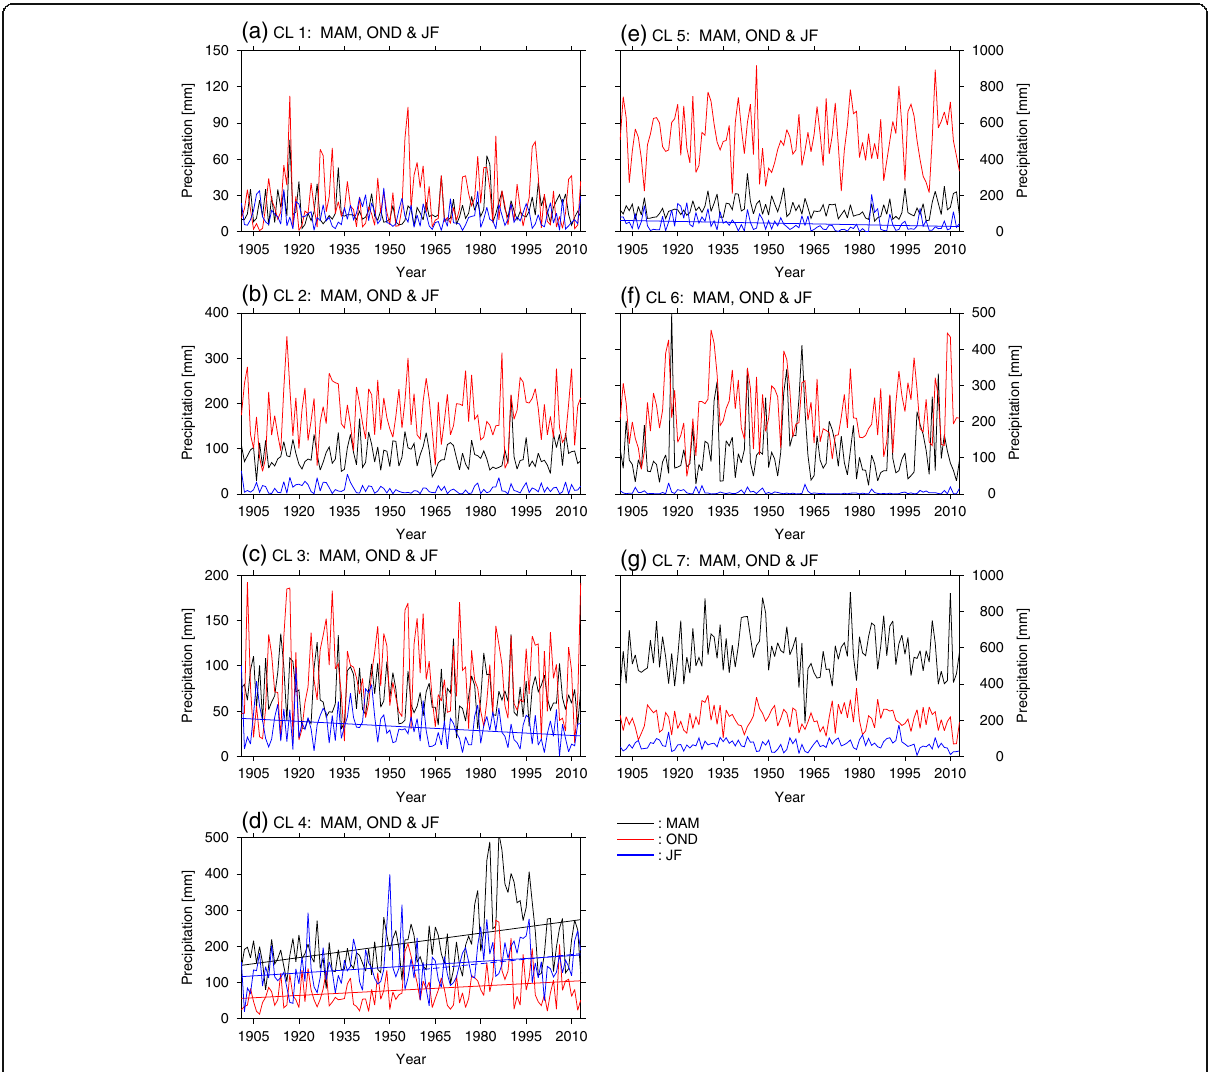
Fig. 5 Secular variation of pre-monsoon (MAM), post-monsoon (OND), and winter precipitation (JF) for each cluster. Time series of MAM (black), OND (red), and JF (blue) precipitation averaged in CL1 ( a ), CL2 ( b ), CL3 ( c ), CL4 ( d ), CL5 ( e ), CL6 ( f ), and CL7 ( g ). The straight line shows the regression of the long-term trend at the 5% significance level for 1901 – 2013 (solid) and 1958 – 2013